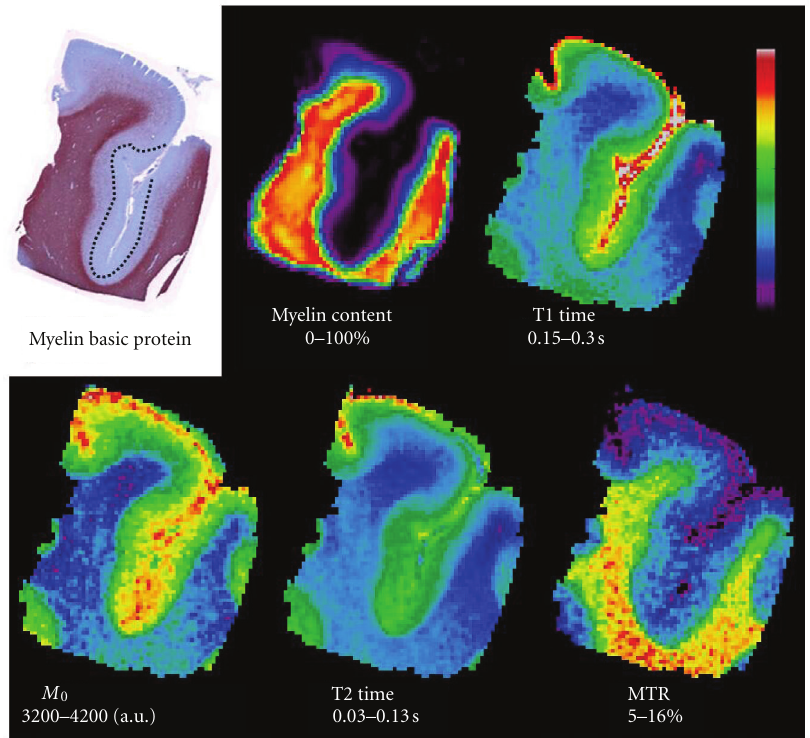
Figure 6: MBP stain, and co-registered myelin content and quantitative MR maps of a section of the superior frontal cortex of the MS brain with a demyelinated lesion in the fundus of the